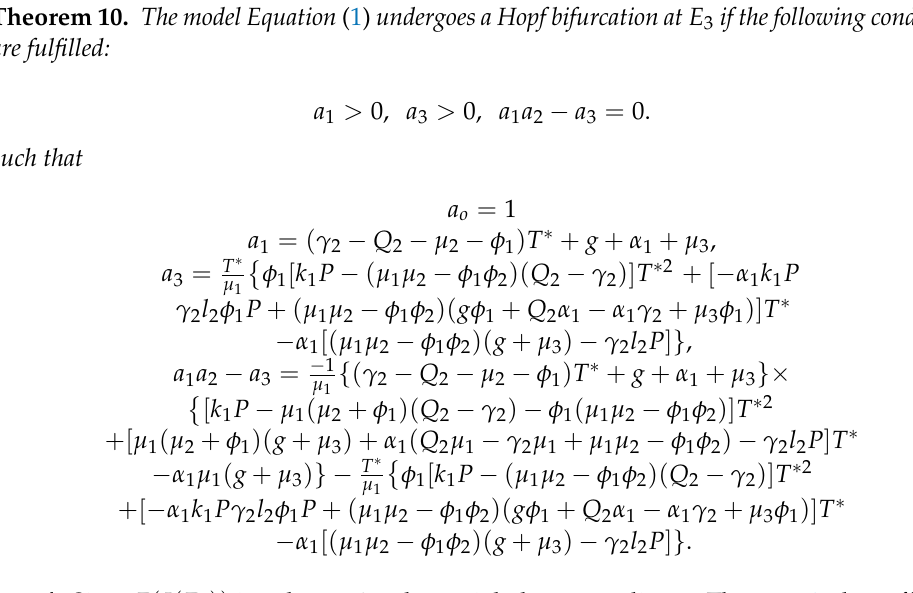
Table 1 enlists the values of all fixed parameters used in the stability or bifurcations analysis. All values in Table 1 are taken from